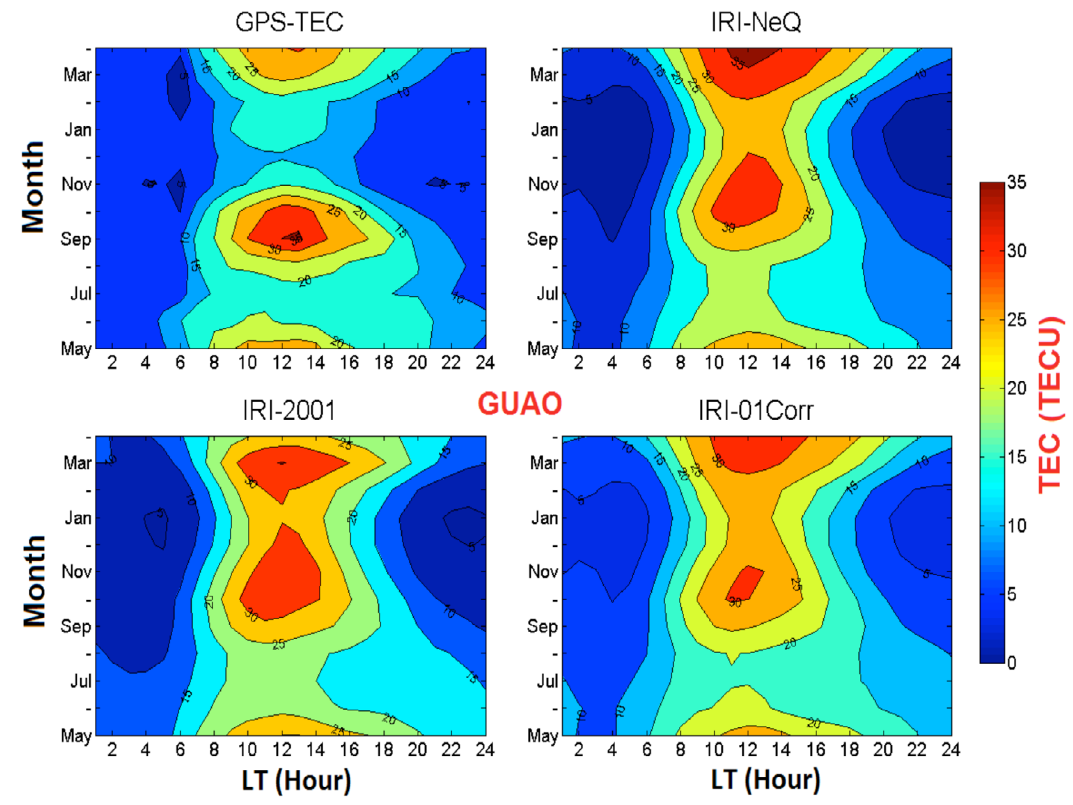
Figure 6. Contour diagram of monthly mean variation of GPS-TEC, IRI 2012 model TEC (NeQuick, IRI- 2001 and IRI-01-corr) at Urumqi (GUAO) (Geomagnetic lat. 34.04°N) from May 2012 to April 2013.